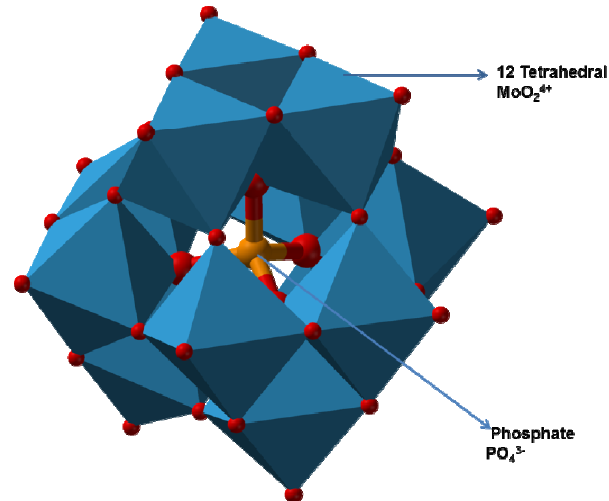
Figure 1. A typical 12-phosphomolybdate structure based on the phosphotungstate structure. The image is under a Creative Commons license. The phosphotungstate structure: ‘Phosphotungstate- 3D-polyhedra’ image was created by Ben Mills (benjah-bmm27). This image is in the public